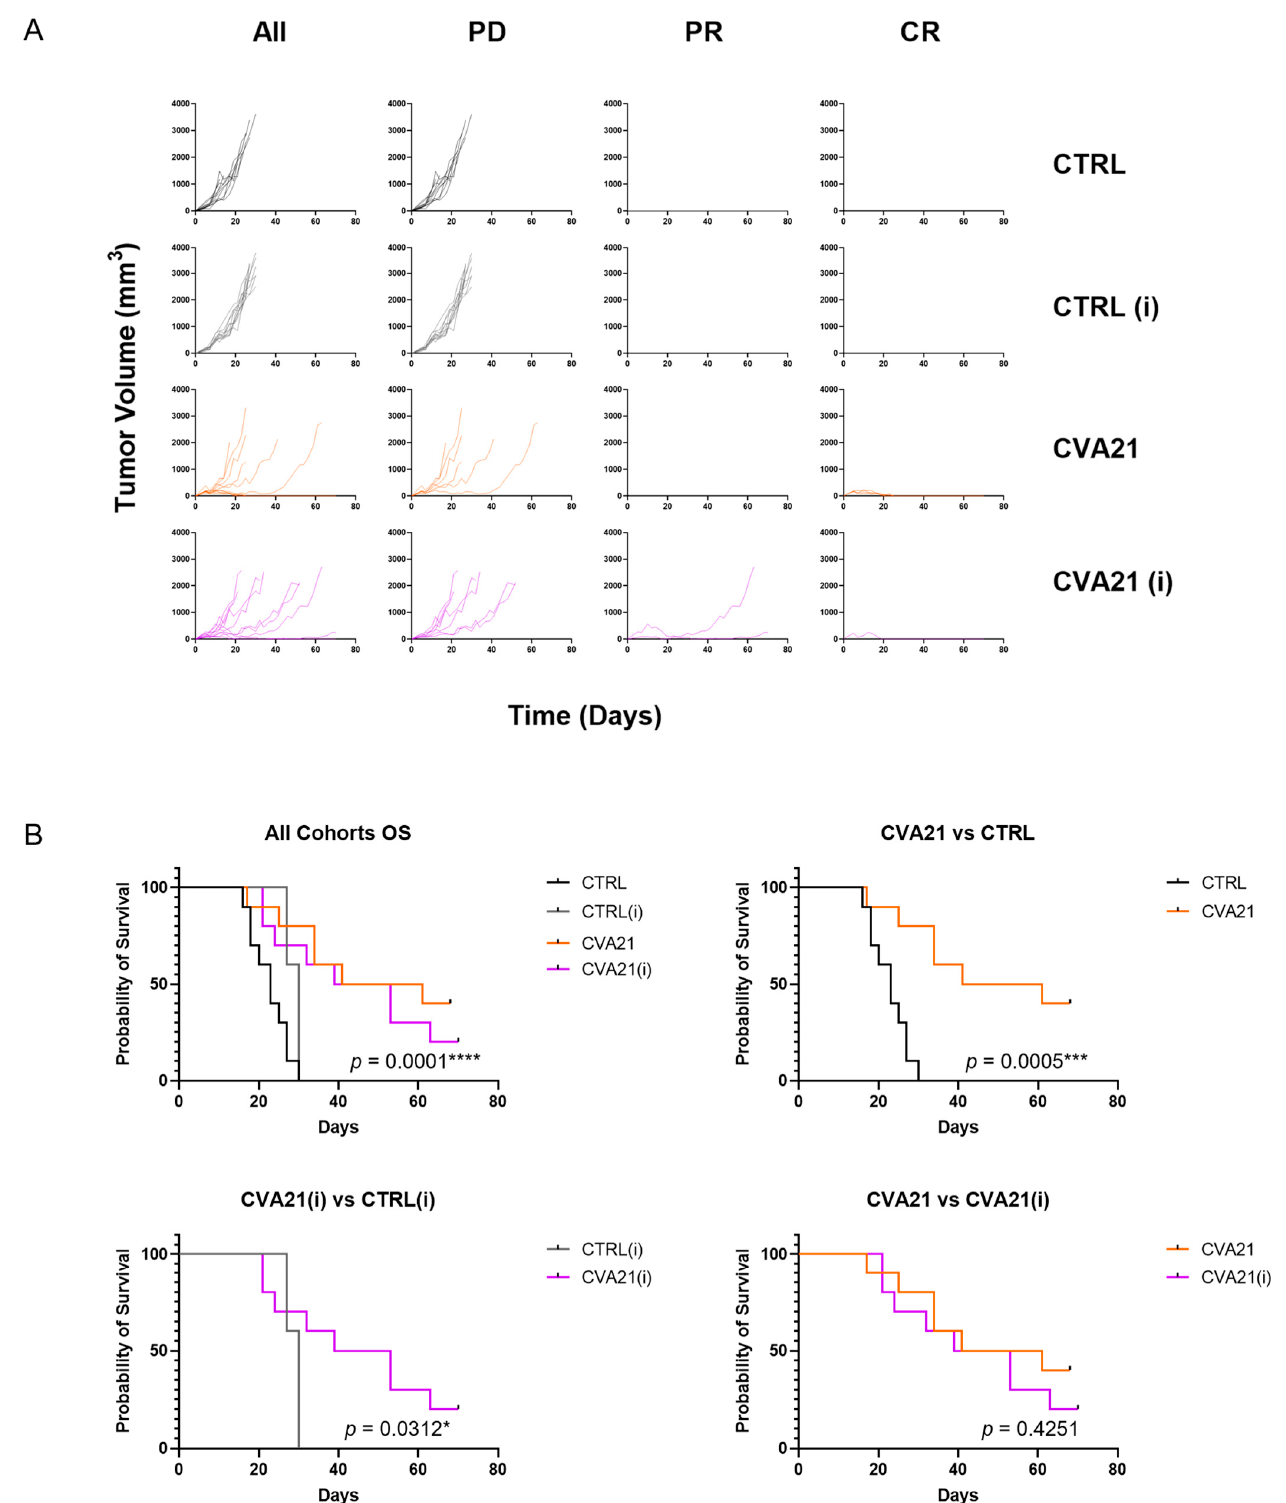
Figure 4. Tumor responses and overall survival in naïve and immunized (i) mice treated with IT saline (CTRL) or CVA21. ( A ) Tumor growth measured in CTRL ( n = 10), CTRL (i) ( n = 10), CVA21 ( n = 10), and CVA21 (i) ( n = 10) treated mice over 70 days. Responses are classified as progressive disease (PD), partial response (PR), or complete response (CR) according to RECIST 1.1 criteria. ( B ) Survival of CTRL ( n = 10), CTRL (i) ( n = 10), CVA21 ( n = 10), and CVA21 (i) ( n = 10) over 70 days. Survival distributions were compared using a Log-rank (Mantel-Cox) test. p values < 0.05 were considered significant ( p < 0.05 *, < 0.001 ***, < 0.0001 ****).